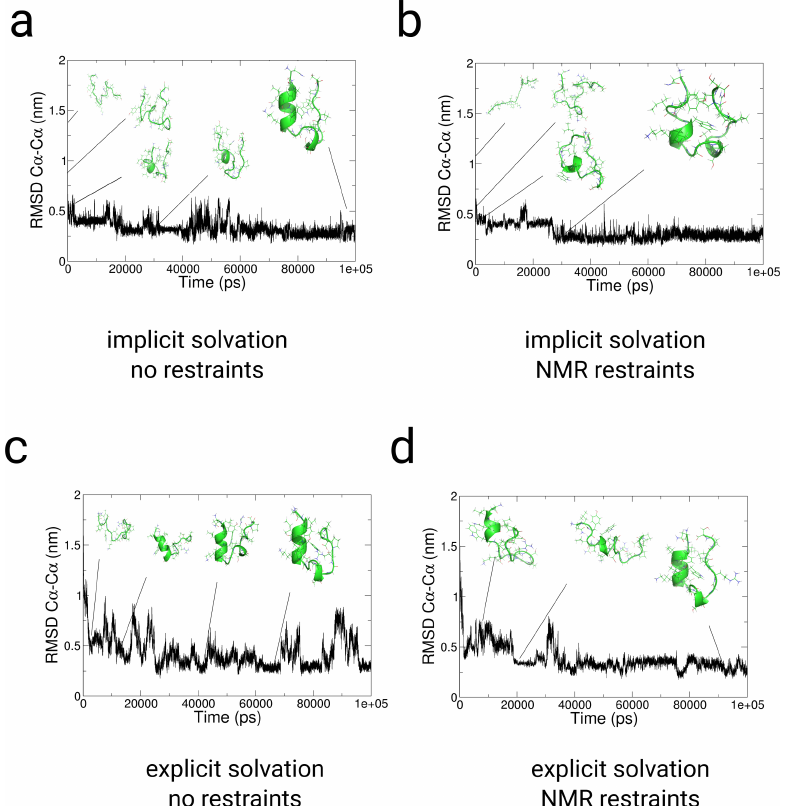
Figure 3. Results from path-sampling simulations with and without restraints from NMR-NOESY measurements of TrpCage starting from an extended conformation [93] in implicit ( a , b ) and explicit solvent ( c , d ). Panels ( a , c ) Results from un-restrained folding simulations of TrpCage in implicit and explicit solvent. Panels ( b , d ) Results from folding simulations of TrpCage with NMR restraints in implicit and explicit solvent. ( a – d ) RMSD C α − C α to the backbone of NMR-model #1 of PDB: 1l2y. In each of the cases, we observe folding to RMSD C α − C α lower than 0.23 nm. The application of the set of restraints ( b , d ) changes the partition of conformations and prevents spontaneous unfolding to configurations at RMSD C α − C α greater than 0.4 nm as we observe in path-sampling simulations without restraints ( a , c